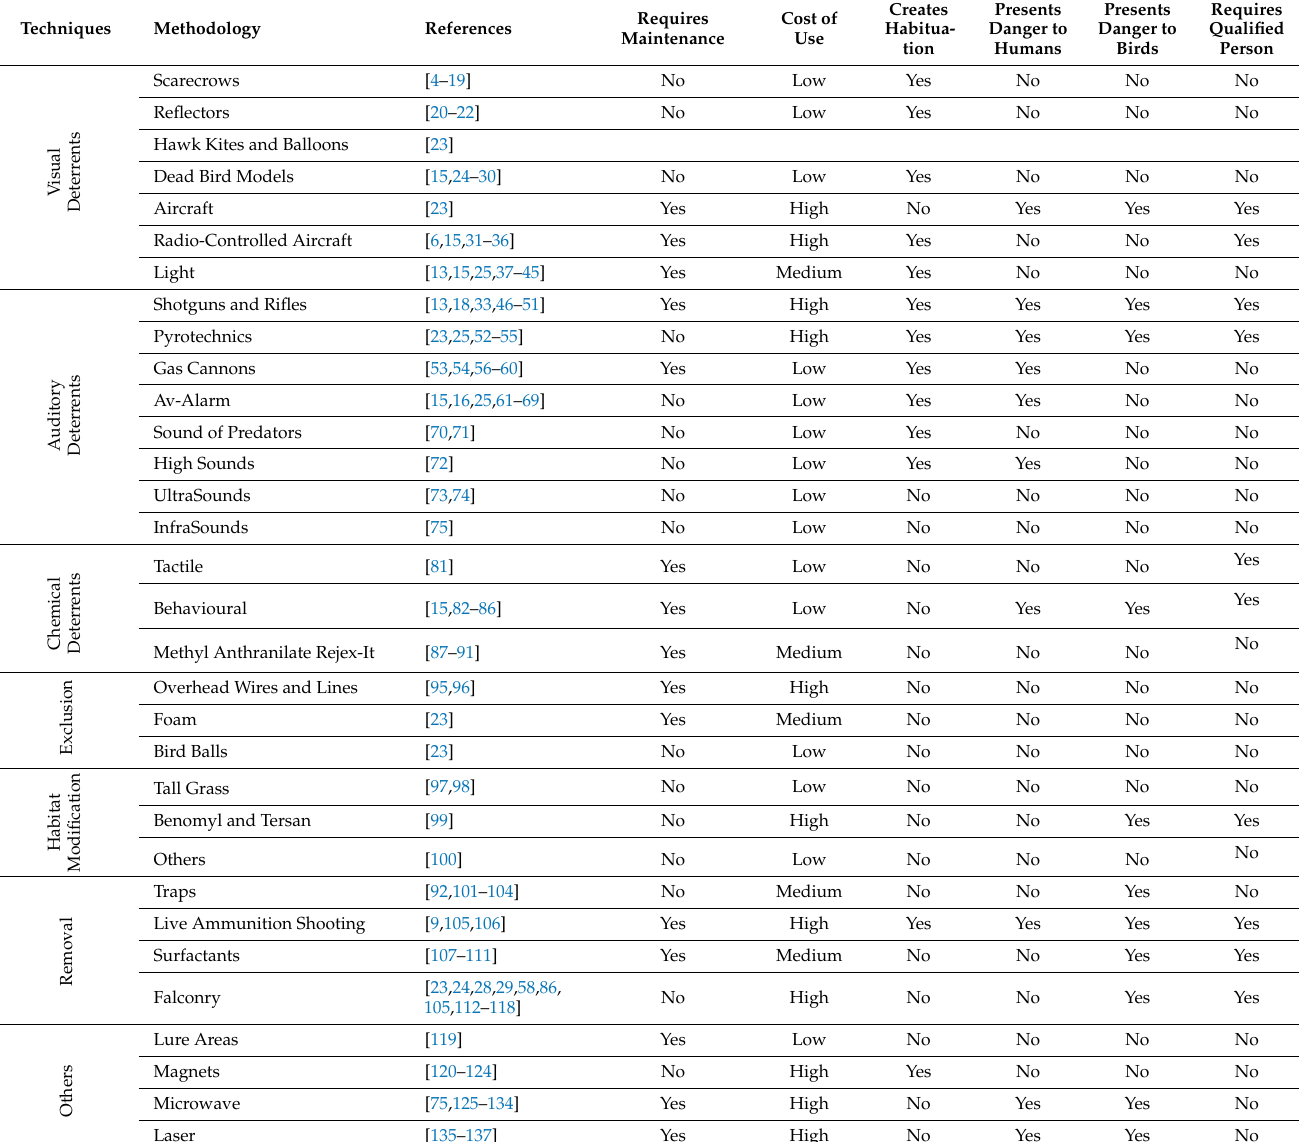
Table 8. Summary of different methods and techniques used as bird deterrent